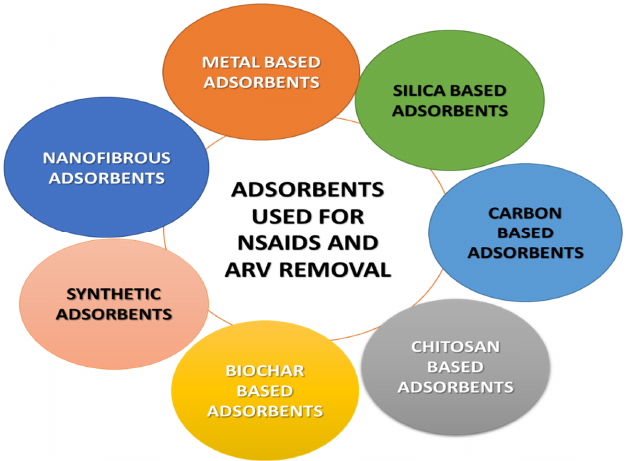
Figure 3. Scheme of various mechanisms used for the adsorption of NSAIDs and ARV drugs on the surface of the adsorbent.